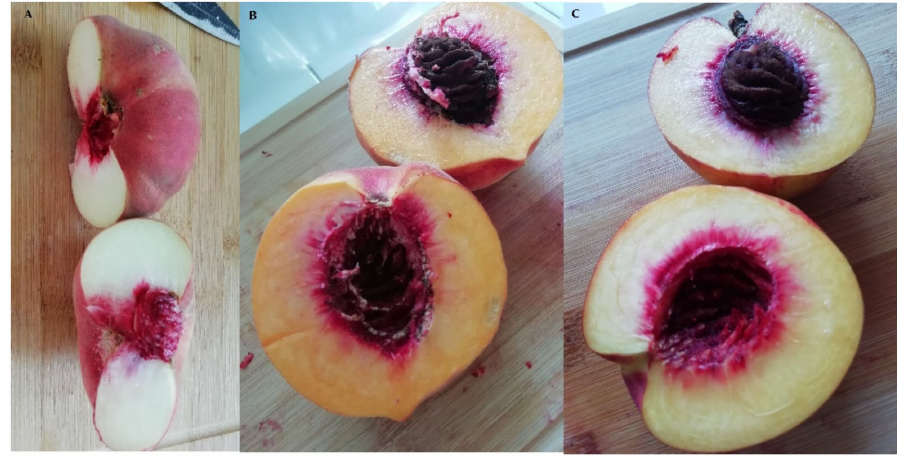
Figure 5. Late season peach ( Prunus persica L.) varieties: ( A ) “Flat queen”, ( B ) “Morsiani 90” and ( C ) “Evmolpiya”.